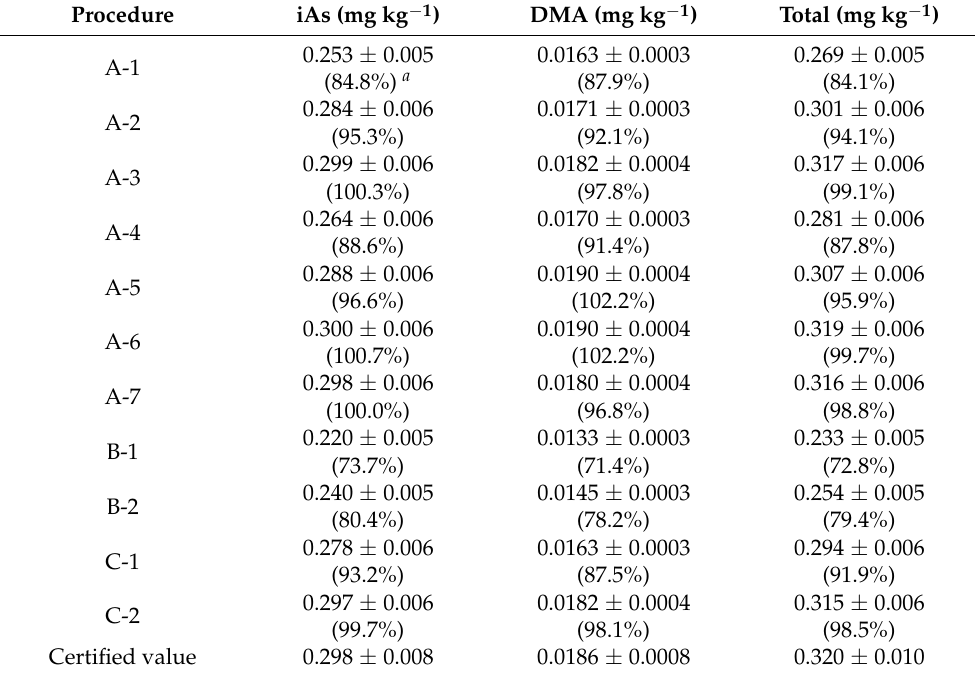
Table 4. Results of arsenic speciation of NMIJ 7532a.